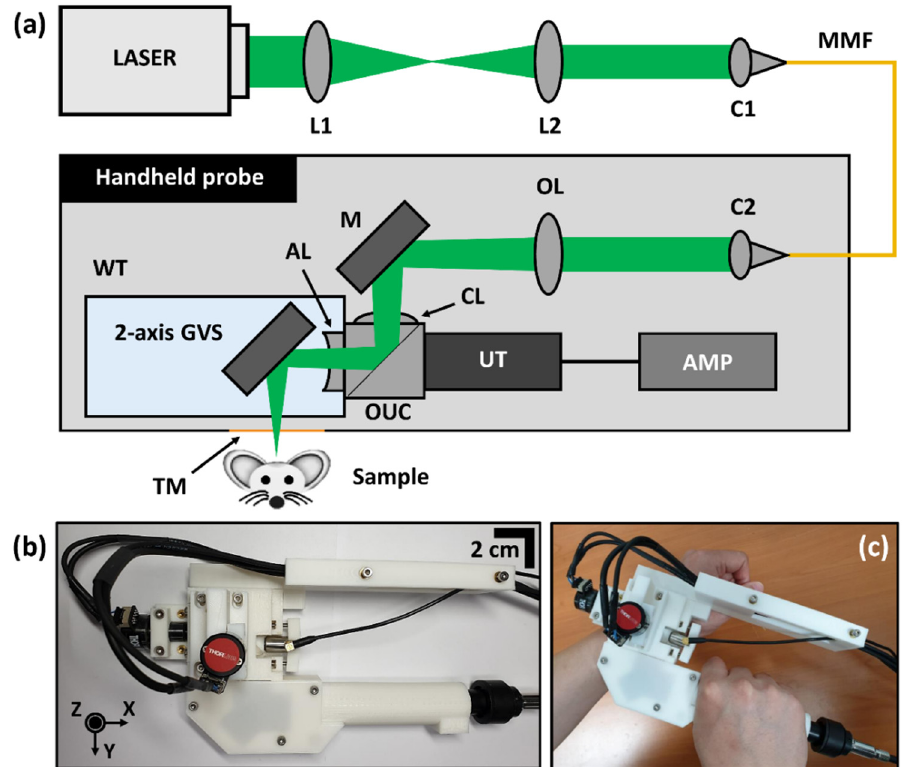
Figure 1. Schematic representation of WP-GVS-HH-PAM. ( a ) Optical configuration of the system. ( b ) A photograph of WP-GVS-HH-PAM probe. ( c ) utilizing WP-WGS-HH-PAM probe for PA imaging. AL, acoustic lens; AMP, amplifier; C, collimator; CL, correction lens; L, lens; M, mirror; MMF, multi-mode fiber; OL, objective lens; OUC, opto-acoustic combiner; TM, transparent membrane; UT, ultrasound transducer; WT, water tank.